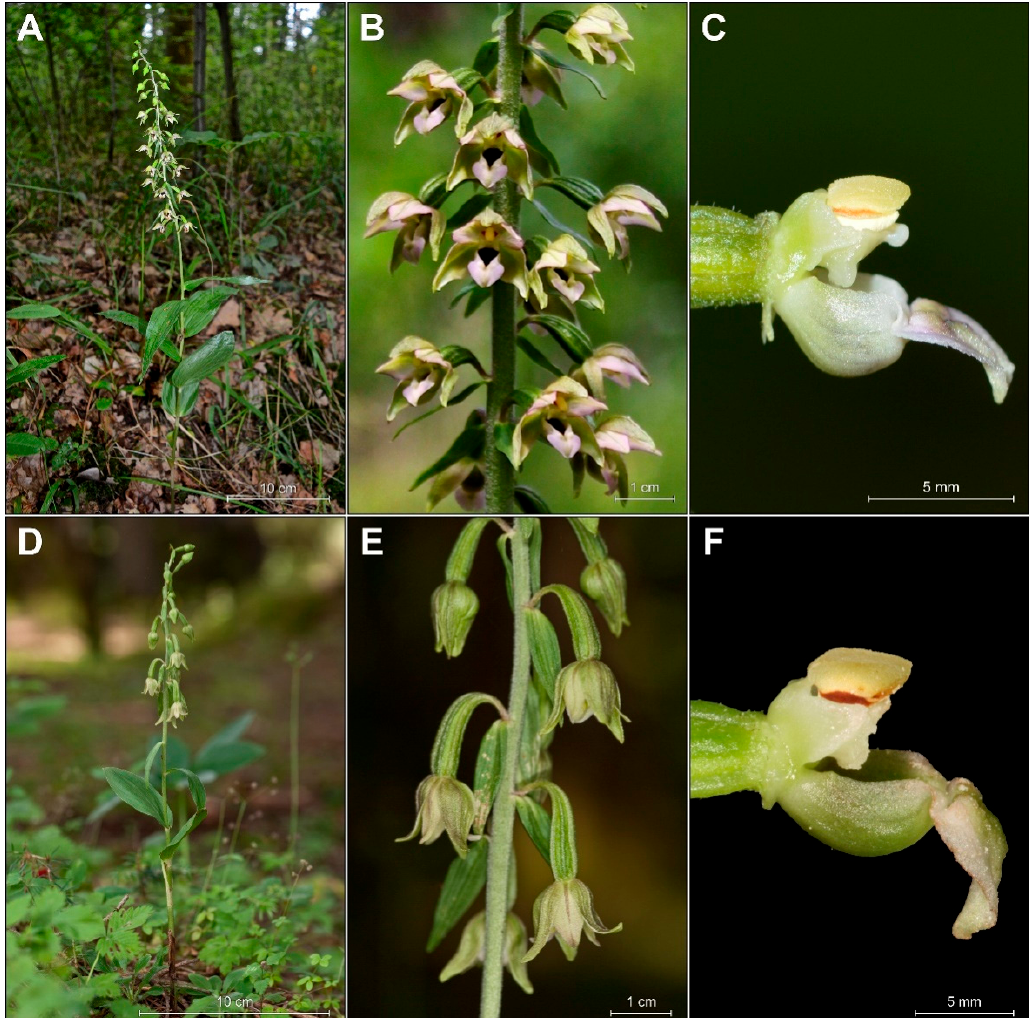
Figure 4. General habit and flower details of the taxa analyzed. ( A – C ) Epipactis helleborine Poland, Milicz, ( D – F ) E. greuteri from Greece, ( D , E ) Peloponnese, Pertouli-Chrysomilea, and ( F ) Romania; ( C ) and ( F ) details of column morphology: ( C ) E. helleborine , ( F ) E. greuteri . The plants analyzed were variable in terms of perianth color. In fresh plants, the petal color was The shape of the gynostemium is significantly different from that of E. helleborine , a common and nearly pinkish, or pale to olive-green. Determination of flower coloration in herbarium / dried material is di ffi cult because of the material dehydration. In addition, the loss of color and strong flattening of plants during the drying process cause deformation of plant organs, especially flowers, leading often to the erroneous taxon